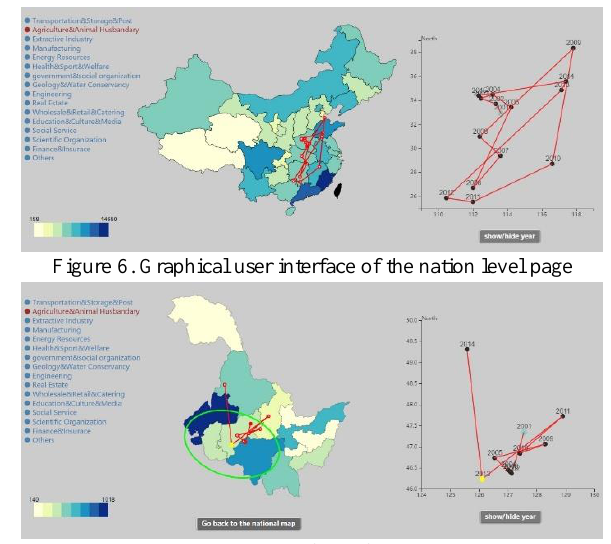
Figure 7. Graphical user interface of the province level page